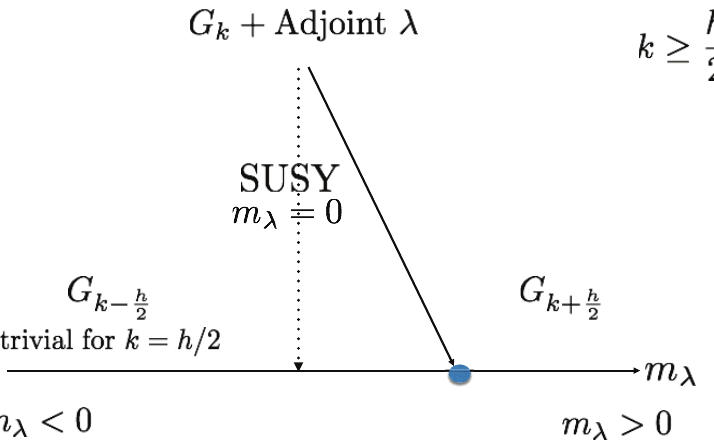
Figure 1: The phase diagram of G with an adjoint fermion for k ≥ h . Note that the k 2 physics at the supersymmetric point is smooth – there is no transition there. For k = h 2 the negative mass phase is trivial and there is a transition at some positive value of m λ . Here, and in all our later figures, the vertical line denotes renormalization group flow from the UV at the top of the diagram to the IR at the bottom of the diagram. The solid diagonal line represents a flow to an IR fixed point. The physics across this line is not smooth. The theory is supersymmetric along the dotted vertical line. Unlike the solid line, here the physics is smooth as this line is